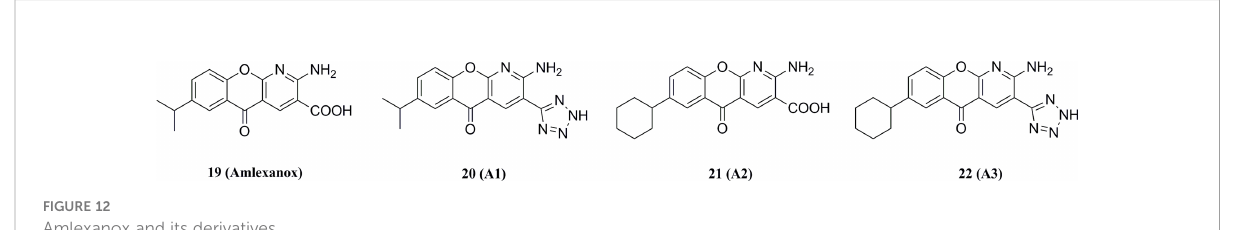
FIGURE 12 Amlexanox and its